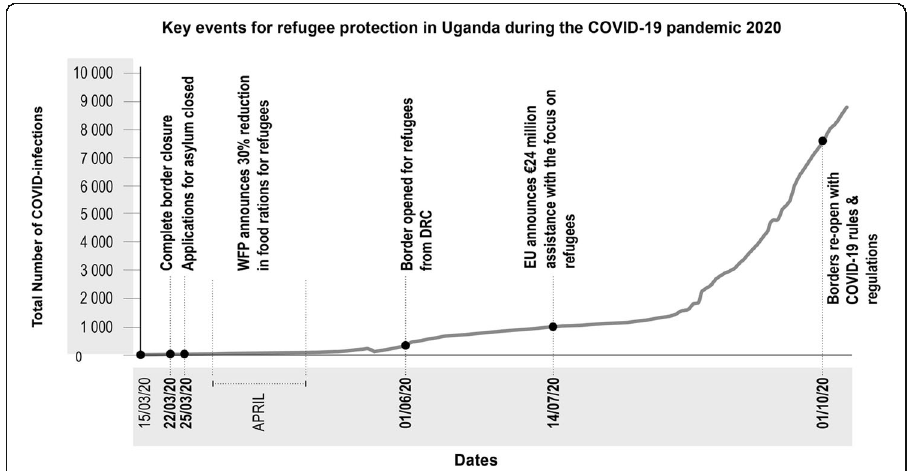
Fig. 2 Key events for refugee protection in Uganda during the COVID-19 pandemic 2020. Source for COVID-19 infections: (Roser et al.,